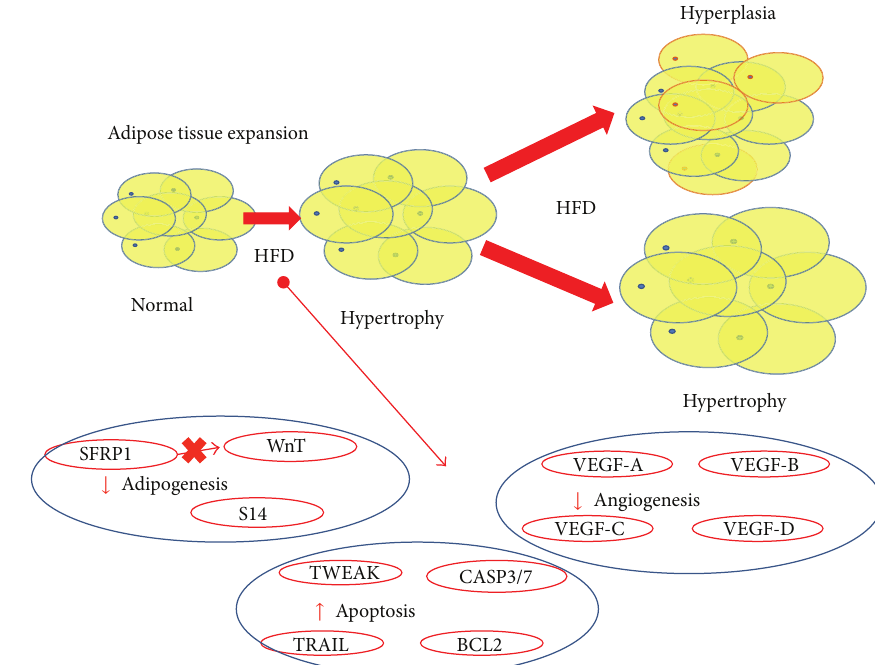
Figure 2: The adipose tissue expansion is produced via hypertrophy in a first point. If the surplus of energy continues, adipose tissue expansion will happen via hyperplasia and/or hypertrophy. In these mechanisms, different mechanisms intervene: adipogenesis, apoptosis, and/or angiogenesis, which will determine the metabolic status of the patient. Moreover, within each mechanism, this adipose tissue can be modulated. HFD: high fat diet; SFRP1: secreted frizzled-related protein 1; S14: thyroid hormone responsive Spot 14; VEGF-A/B/C/D: vascular endothelial growth factor A/B/C/D; TWEAK: TNF-like weak inducer of apoptosis; CASP3/7: Caspasas3/7; BCL2: B-cell lymphoma 2; TRAIL: TNF (tumor necrosis factor)-related apoptosis-inducing